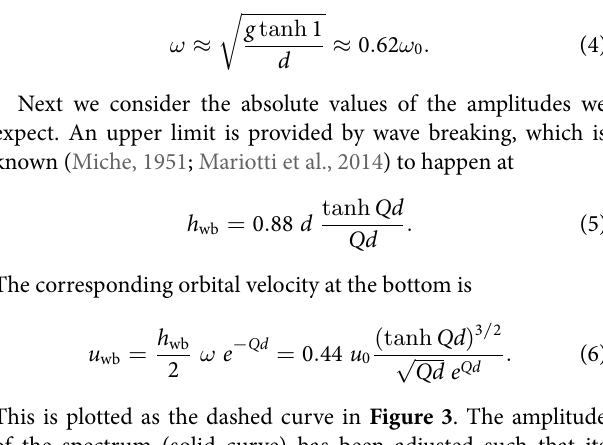
FIGURE 4 | The prediction of the oscillating flow model for the wavelength of the Kinneyia pattern . The hatched region indicates the observed wavelengths, while the cross-hatched region indicates the region of water depth for which the predictions of the OF model agree with the observations from the fossil record. The inset shows the orbital velocity at the bottom, u orb , as a function of water depth, d . According to Figure 3 , the dashed line representing u orb = 0.1 u 0 is relevant. The gray shaded area represents orbital velocities relevant to the OF model. For any depth of the water body larger than about 8cm, wave breaking is clearly irrelevant to the OF